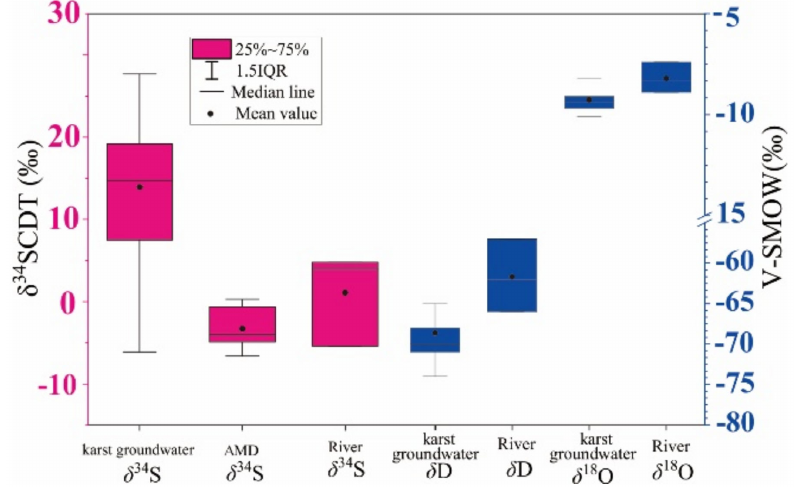
Figure 7. Box chart of stable isotopes in the AMD, river, or karst